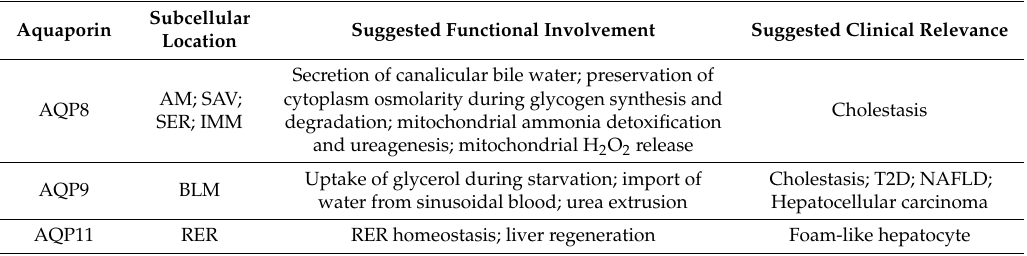
Table 1. Subcellular localization and suggested significance of hepatocyte aquaporins (AQPs) in health and